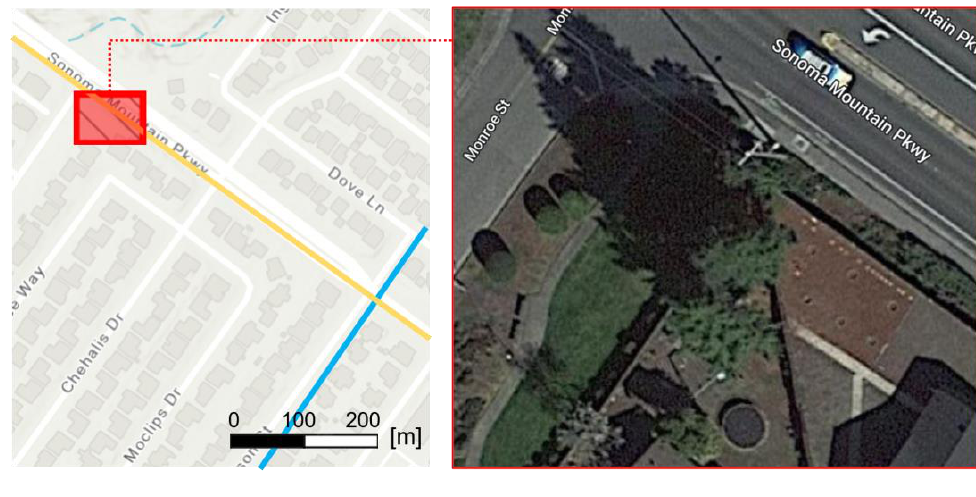
Figure 1. The study area in Sonoma County in northern California.